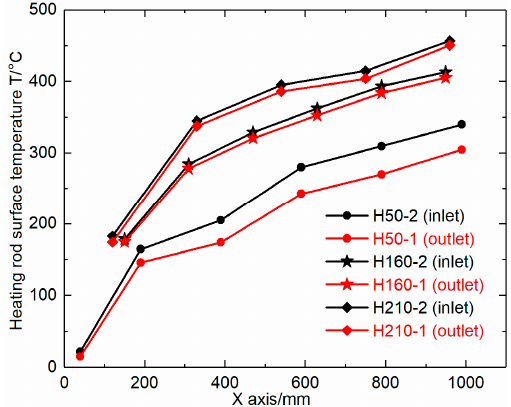
Figure 5. Heating rod surface temperature ( T ) with respect to x axis.